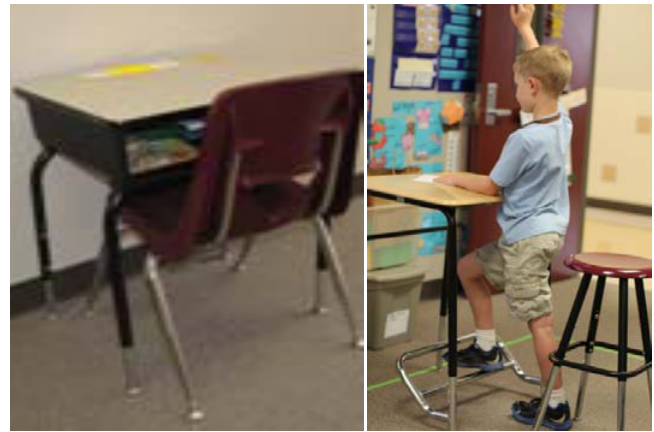
Figure 1. Stand-Biased & seated desk (photos courtesy of PositiveMotion LLC).